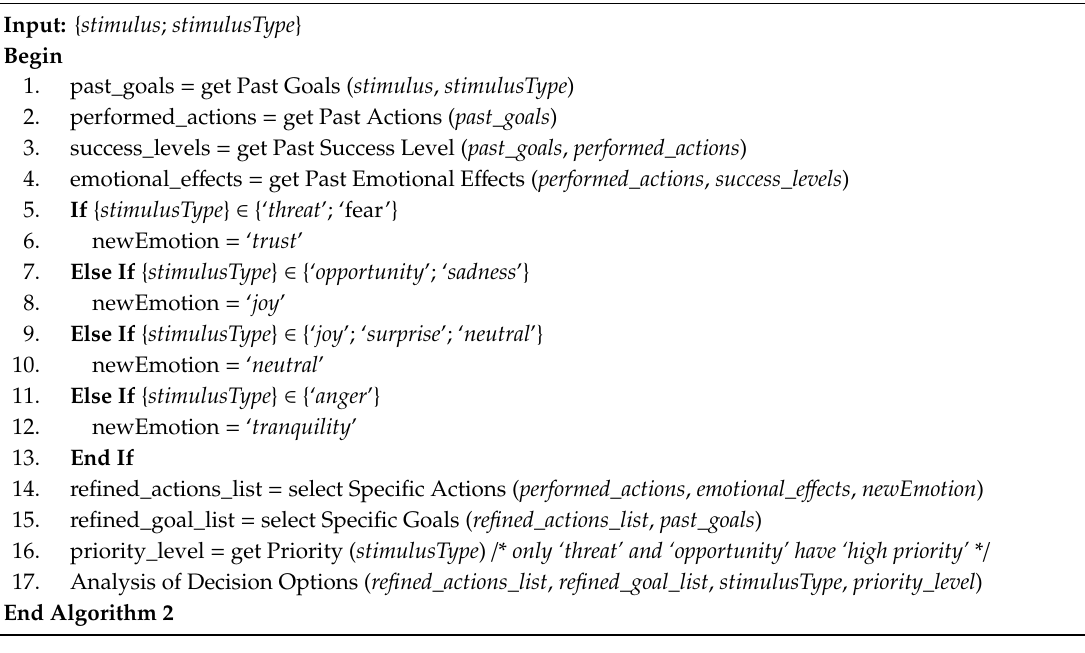
Algorithm 2 Determination of the Courses of Action